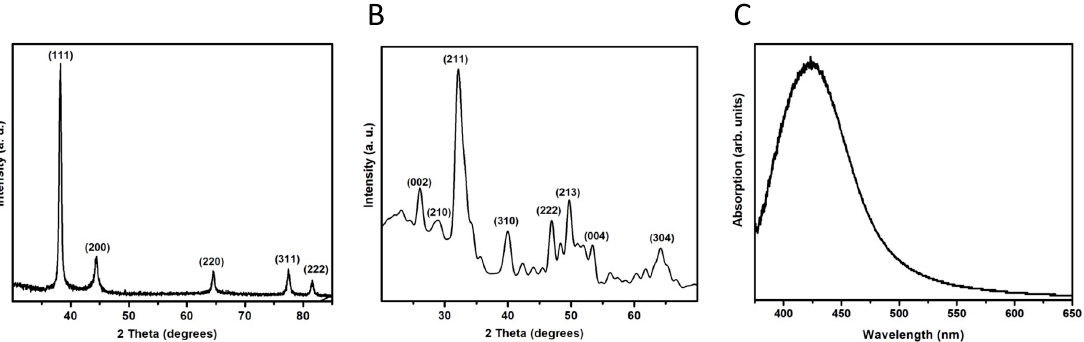
Figure 2. X-ray diffraction patterns of the NPs synthesized in this study. ( A ) AgNPs. ( B ) NHAPs. ( C ) Surface plasmon resonance of AgNPs.